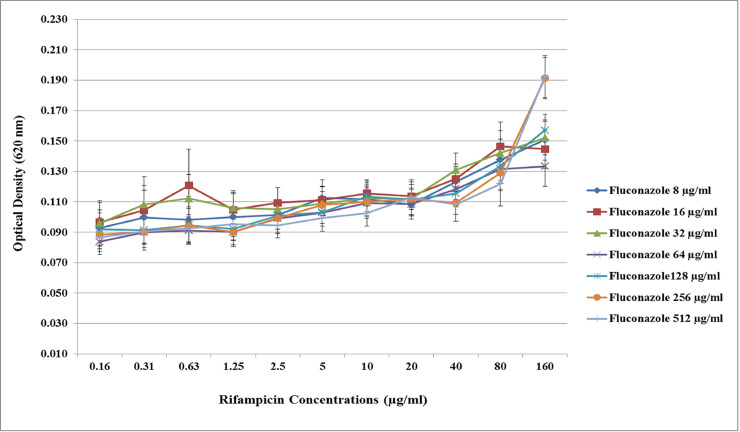
Effect of rifampicin to the fungicidal activity of fluconazole on the fluconazole resistant C. albicans.The Optical Density (OD) of the checkerboard microdilution assay results was measured. The colors of the line charts represent the different concentrations of fluconazole. The presence of rifampicin increased the OD of the cultured C. albicans, which correlates with the dose dependent increase in the population of viable yeast for all fluconazole concentrations. The ANOVA test showed significant difference in OD only for those with high fluconazole concentration (≥ 32 μg/ml) (p<0.05). The results were shown with the standard error of triplicate individual experiments of 8 fluconazole resistant C. albicans isolates.